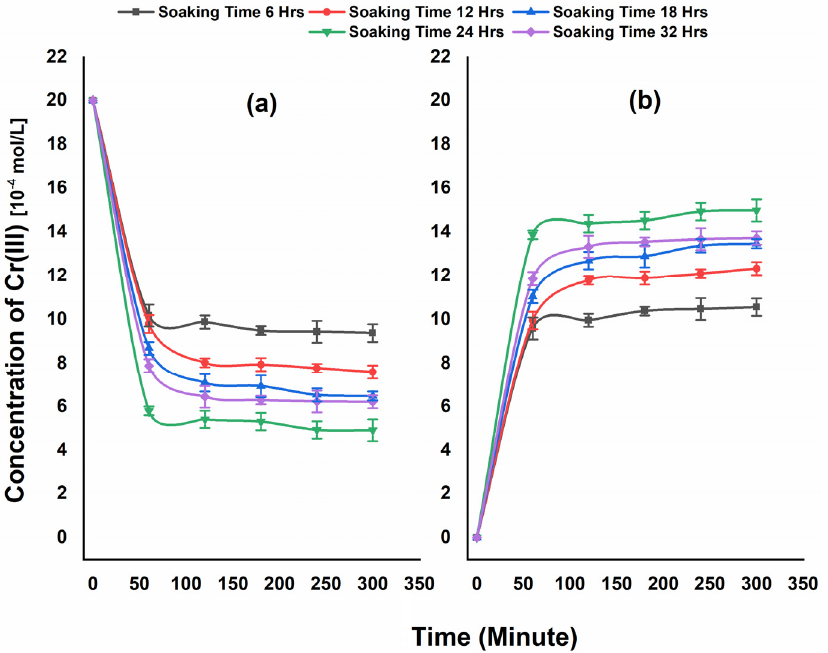
Figure 5. Variation of ion ( a ) feeding and ( b ) stripping; [CrIII] = 20 × 10 − 4 mol/L, [D2EHPA] = 0.3 mol, [HCl] = 1.25 mol/L.